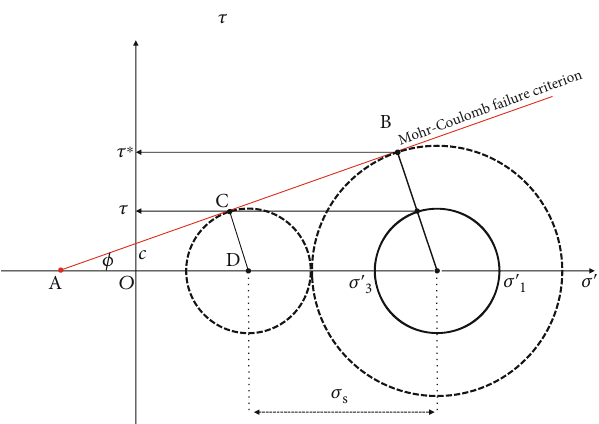
Figure 3: Conception of the local factor of